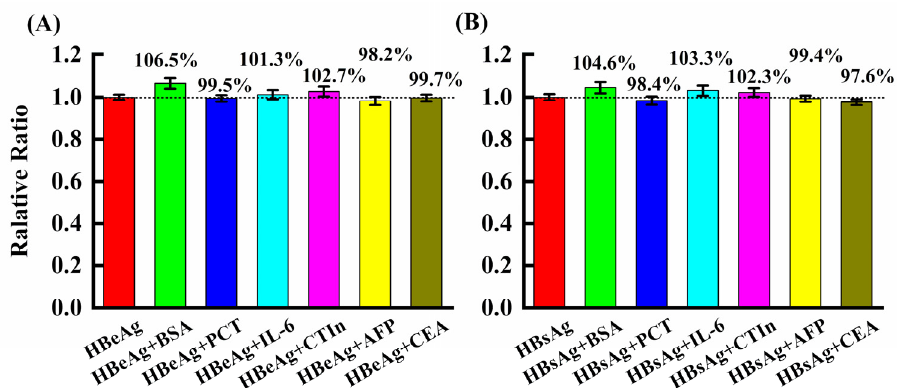
Figure 5. Interference effects from various substances in 50 ng / mL HBeAg ( A ) or HBsAg ( B ) solution. The concentration of each substance is 5.0 µ g / mL. Error bars (standard deviation of three replicated assays).